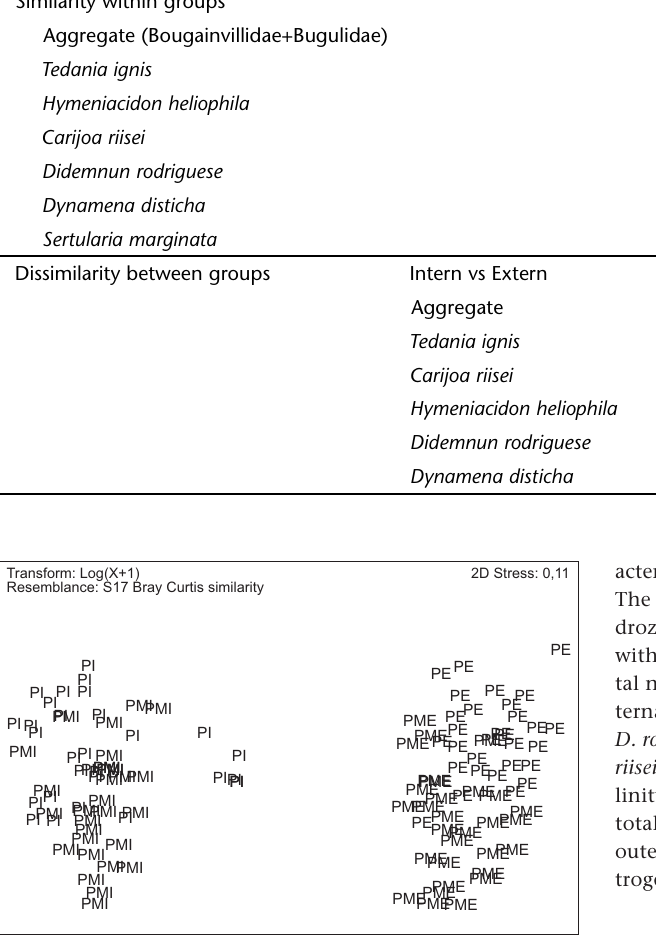
Figure 16. Multidimensional Scaling Analysis (MDS) for 30 samples/ station (N = 5 quadrats on six sampling dates) on four study sta- tions using the percent cover of each taxon on each quadrat and date: PI (Internal Station), PMI (Internal Midpoint), PME (External Midpoint) and PE (External Station) along the Vitória Harbor.